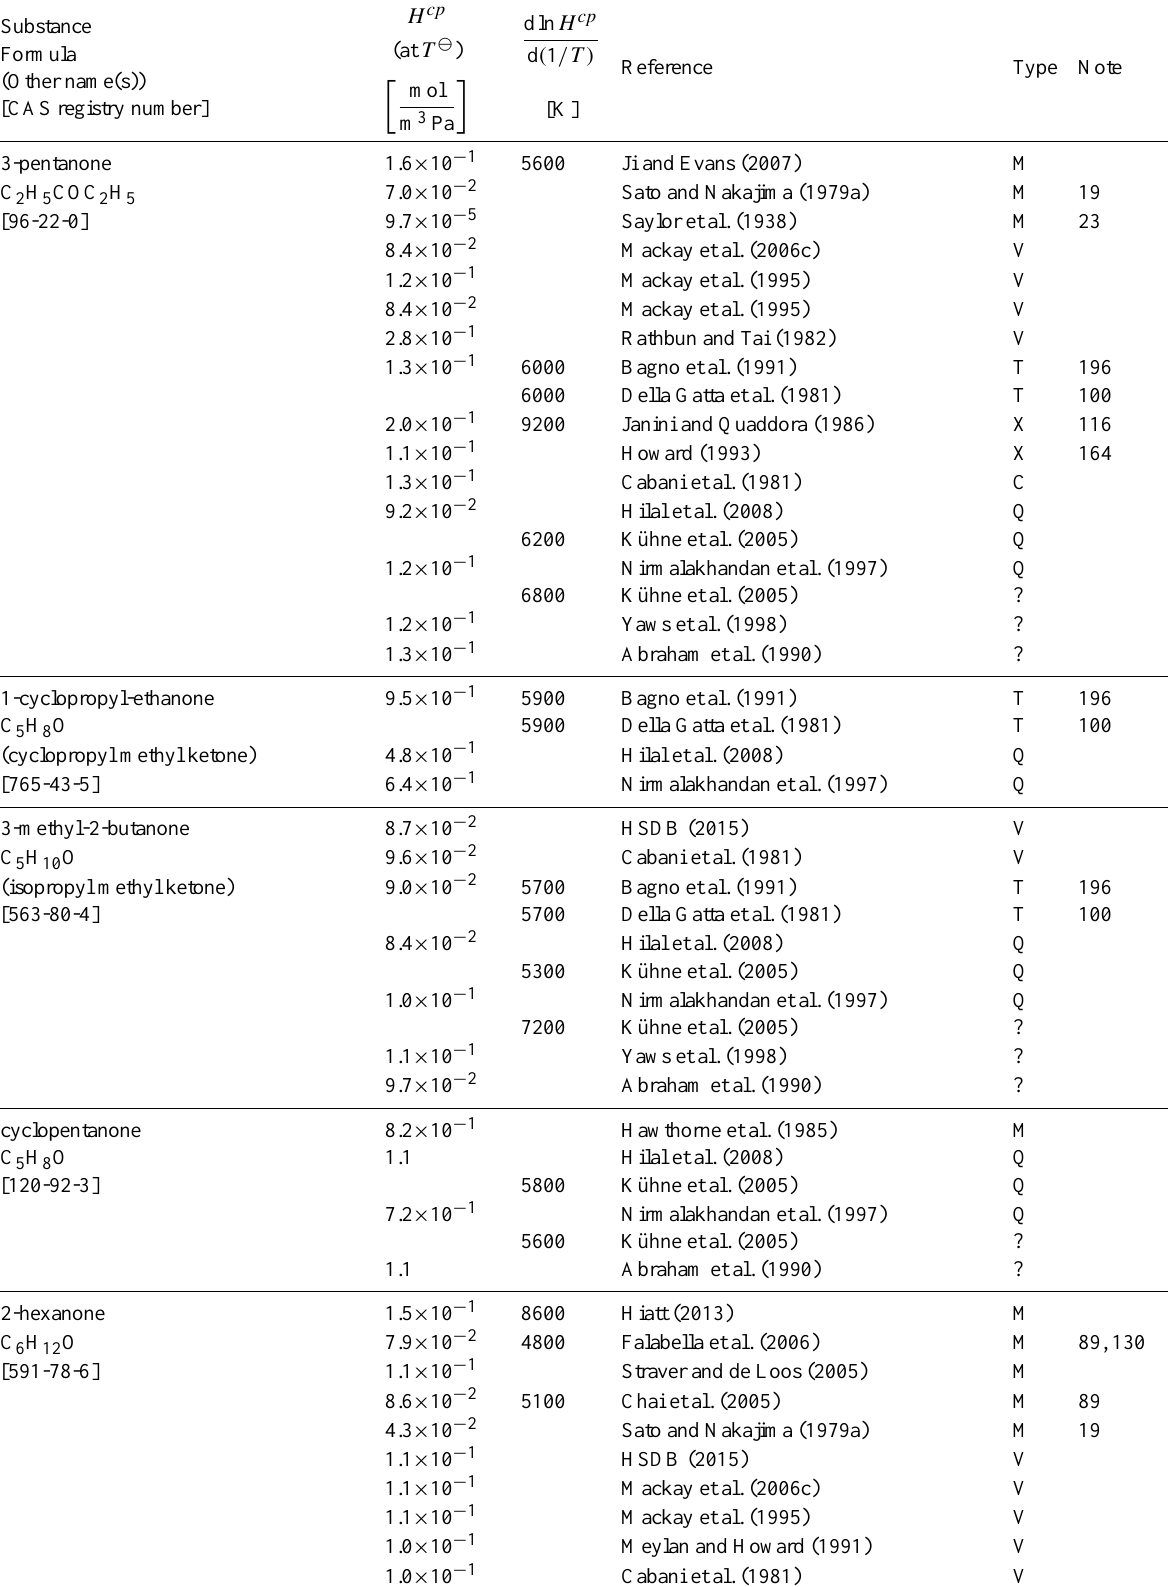
Table 6: Henry’s law constants for water as solvent